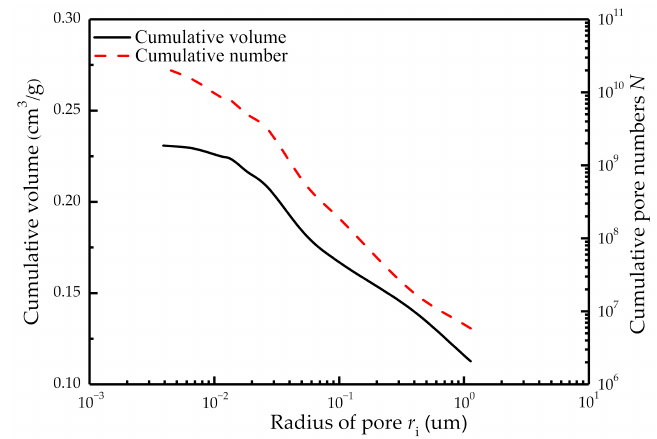
Figure 6. Pore size distribution determined by the soil freezing curve.